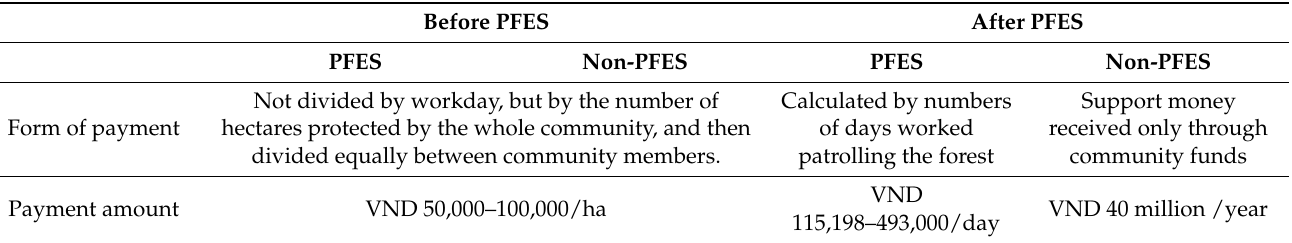
Table 9. Payment rates for forest protection contracts before and after PFES.